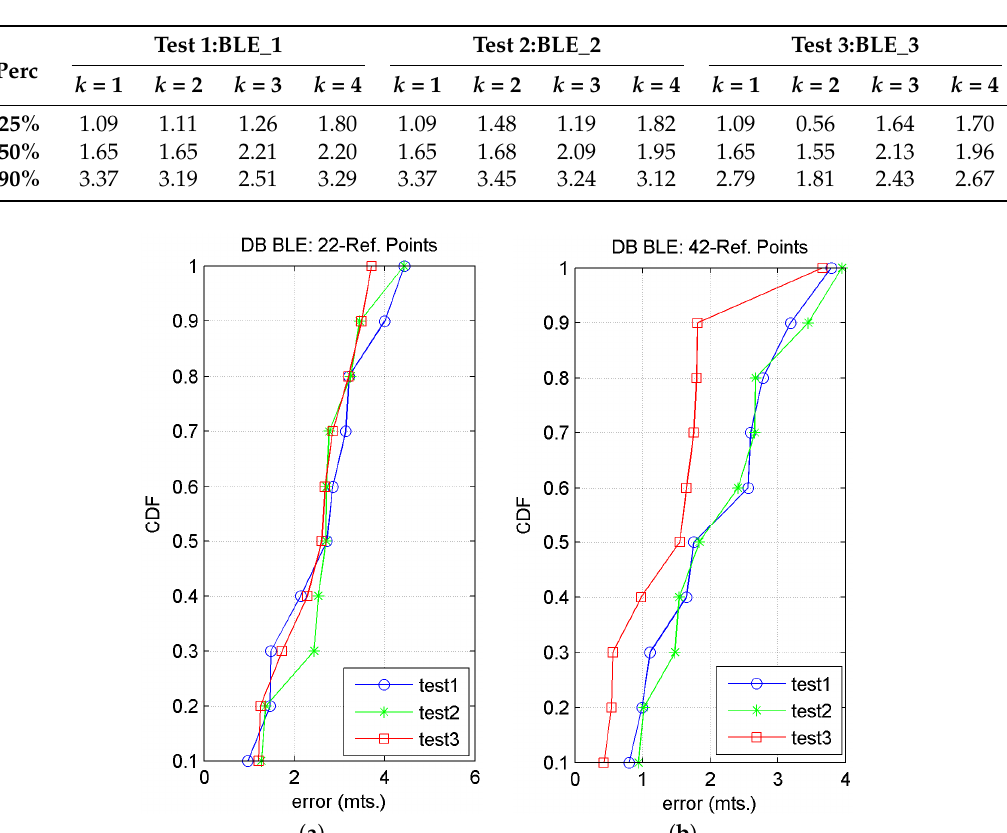
Figure 18. Precision (CDF) for Test 1, 2 and 3 with 22 and 42 reference points.